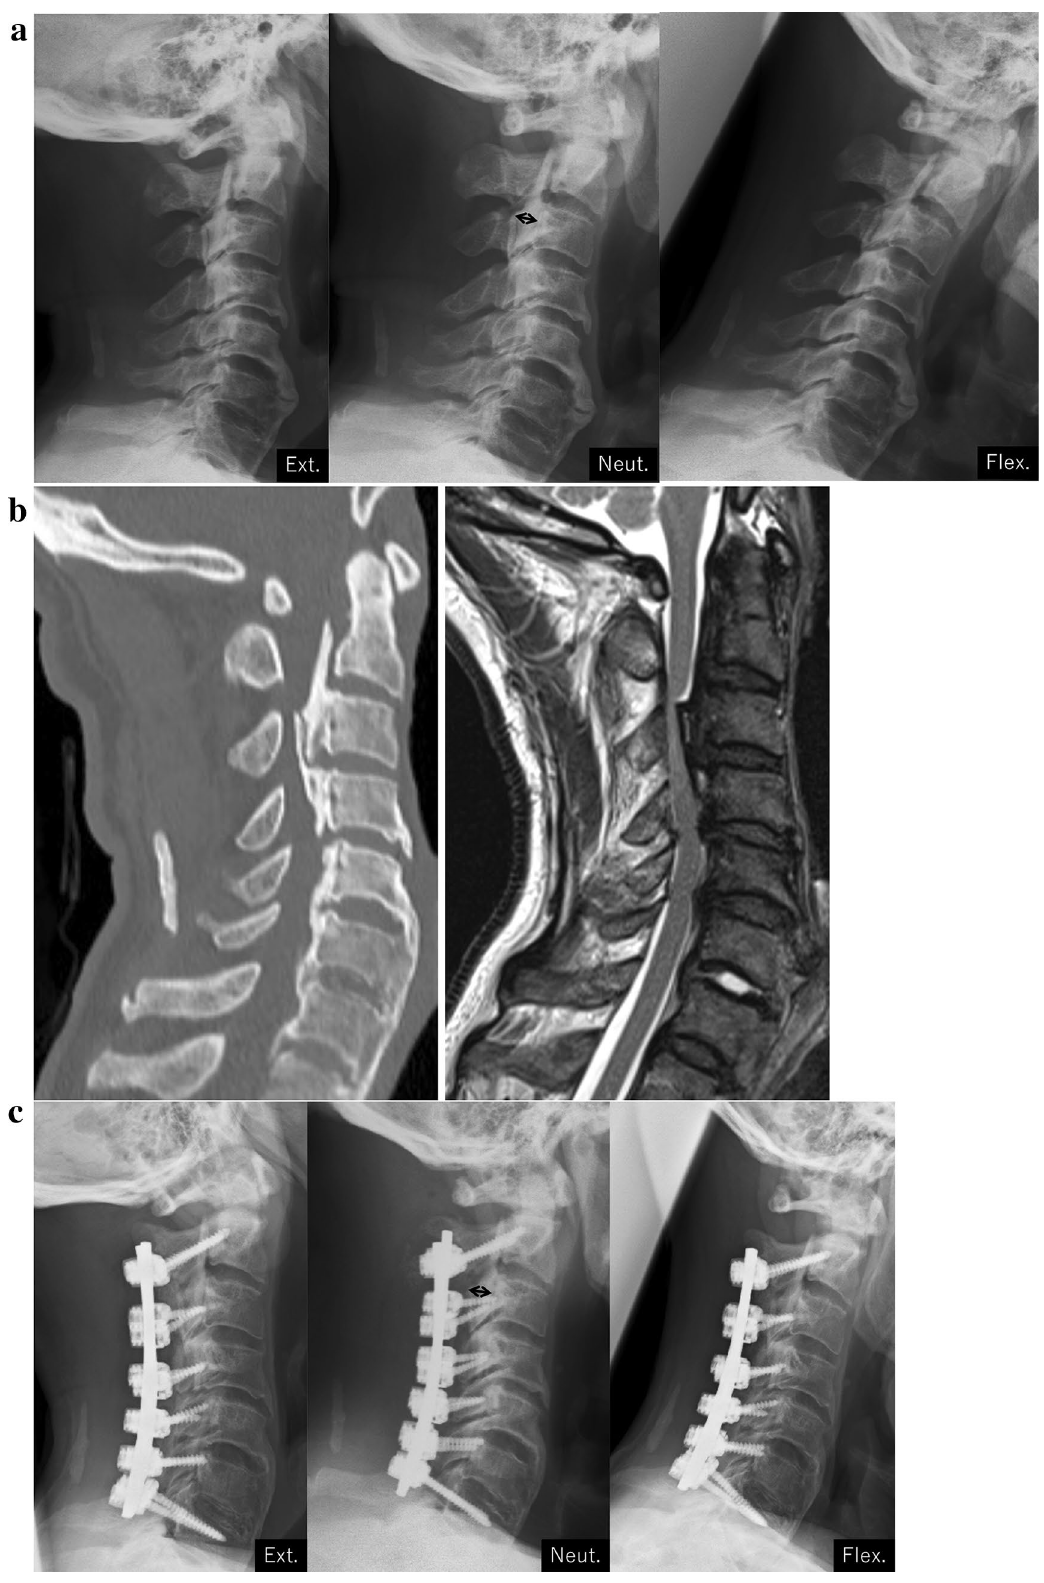
Figure 3. A representative case of cervical posterior fusion. ( a ) Preoperative functional X-rays. The thickness of OPLL was 8.0 mm (double-arrow). The neutral position and range of motion at C2–C7 were 11° and 20°. ( b ) Preoperative CT and MRI sagittal images. ( c ) 2 years postoperative functional X-rays. The thickness of OPLL was 7.4 mm (double-arrow). The neutral position and range of motion at C2–C7 were 19° and